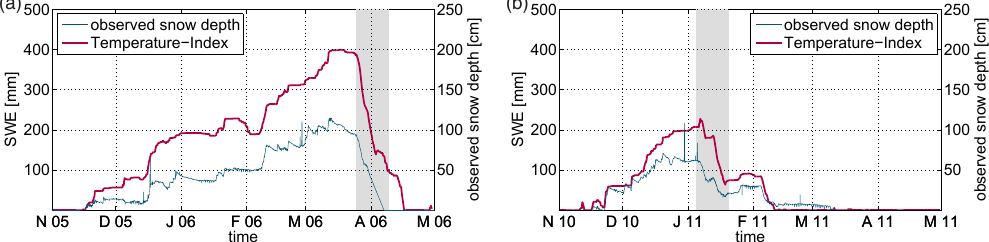
Figure 4. Comparison of simulated SWE and observed snow depth time series at the Torfhaus meteorological station: (a) winter season 2005–2006, (b) winter season 2010–2011. Both simulations were performed using observed meteorological time series. The shaded area refers to the corresponding melt period (see, Fig. 5).